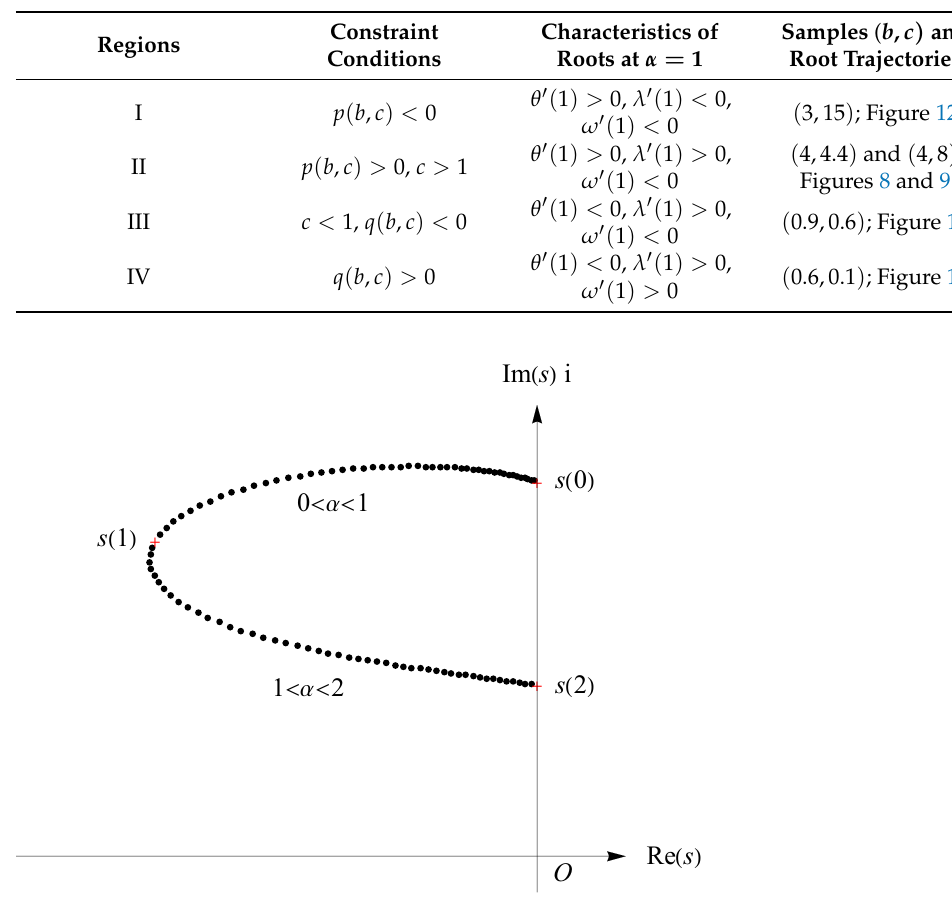
Figure 11. Local zoom of the rectangular area 0 ≤ b ≤ 2, 0 ≤ c ≤ 1 in Figure 10. Table 1. Characteristics of four regions in the domain b 2 − 4 c < 0.